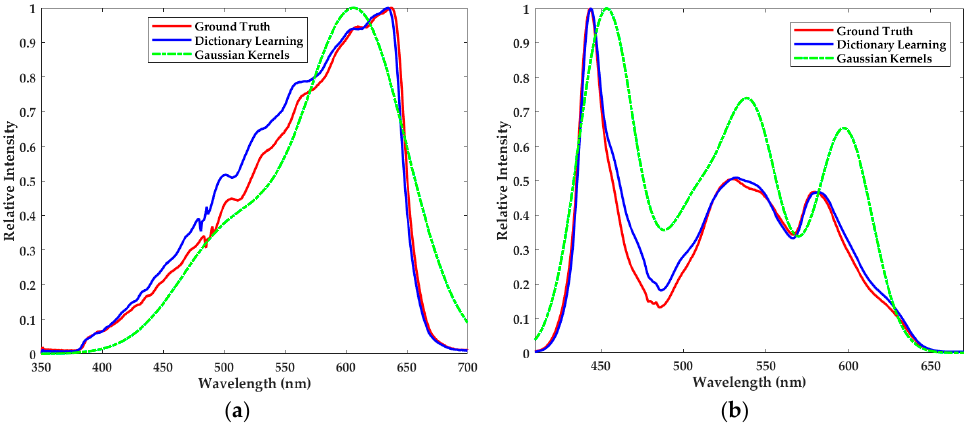
Figure 7. The ground truth (red) and the reconstructed spectra of ( a ) the halogen lamp and ( b ) LED using the learned dictionary (blue) and Gaussian kernels (green).